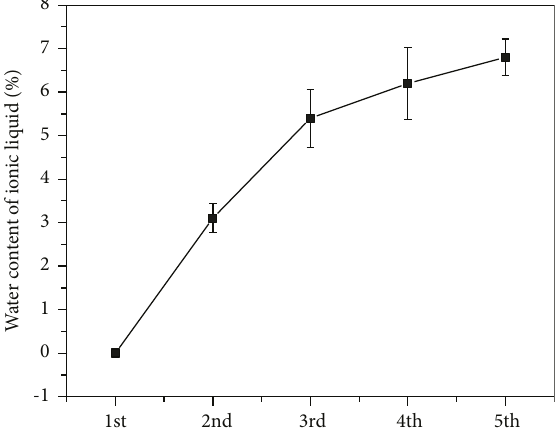
Figure 7: The water content of [BMIM]MeSO times. Figure 8: E ff ect of water addition on lipid yield extracted by